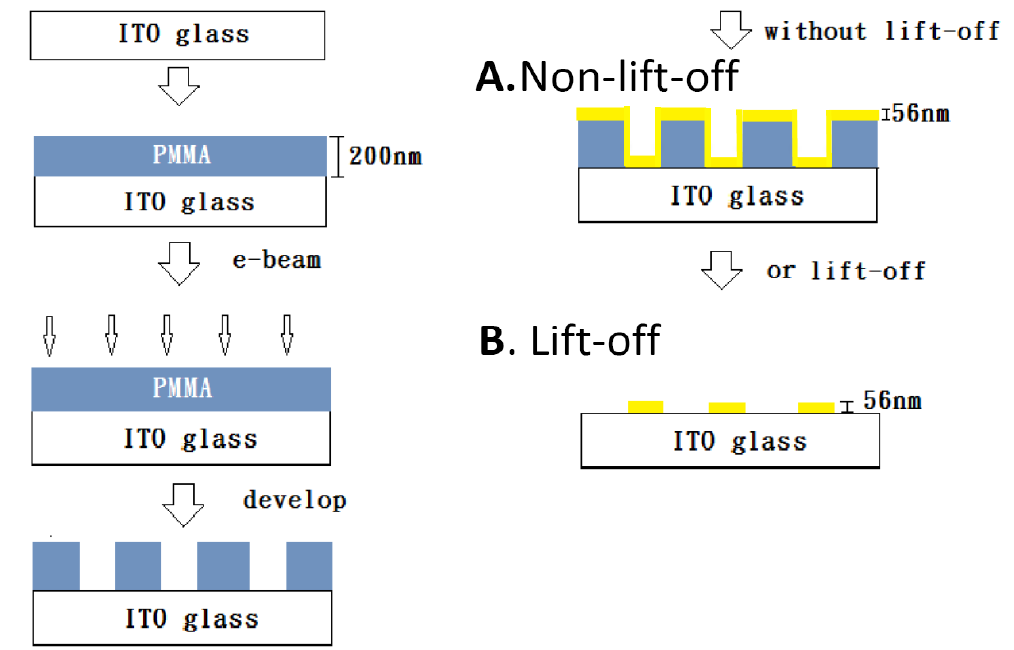
Figure 1. Schematic of the sample fabrication procedure. A layer of polymethylmethacrylate (PMMA)